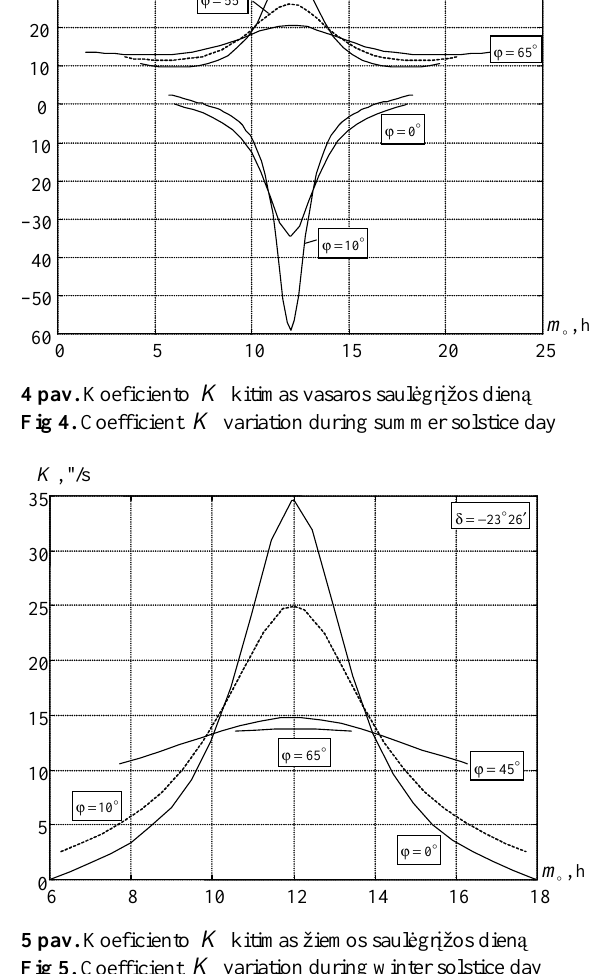
Fig 5. Coefficient K variation during winter solstice day Iš formul ė s (8) matyti, kad platumos ir Saul ė